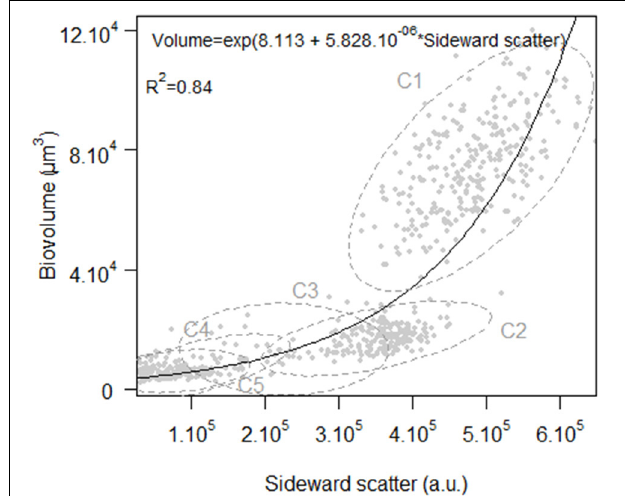
FIGURE 2 | Cytogram total red fluorescence vs. total sideward scatter (a.u.) with 95% confidence ellipses for the various clusters optically resolved during this study. The “image-in-flow” window used to trigger the picture acquisition is represented by the black square.